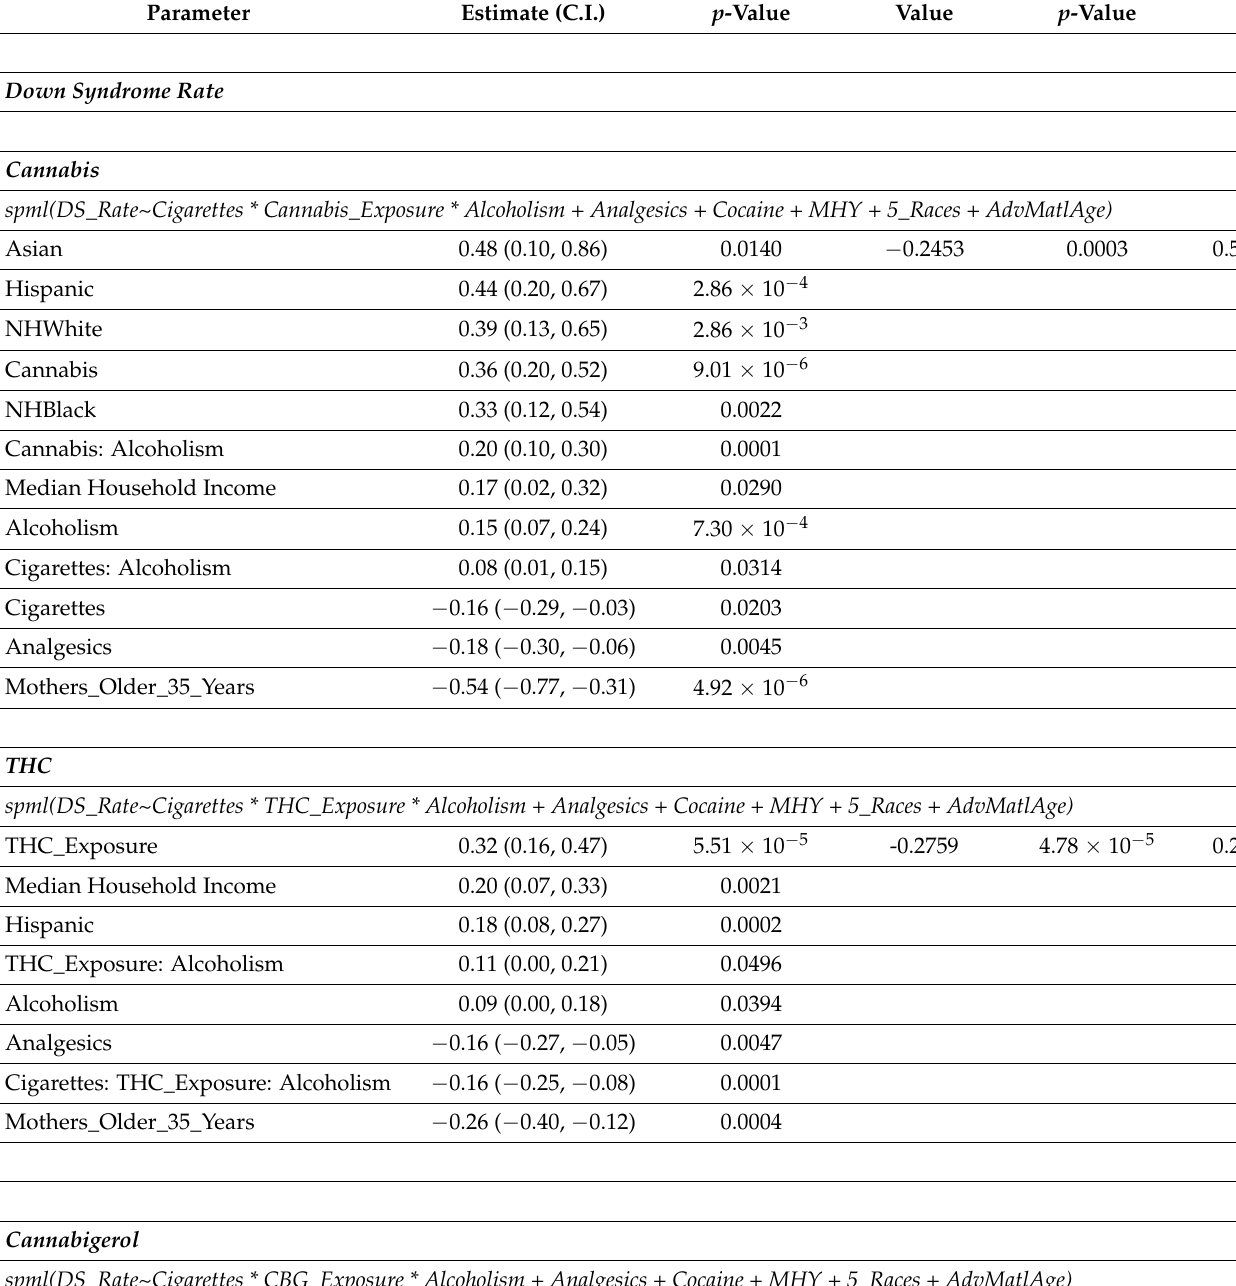
Table 1 shows the results from spatial regression of this data for multivariable models including cannabis, THC and cannabigerol including all the main socioeconomic, ethnicity and drug exposure variables. Table considers first the unadjusted DSR and then the DSR after adjustment for estimated ETOPFA rates. In each case first cannabis, then THC and then cannabigerol are considered. The columns of the right hand of the table list the value of the spatial coefficient rho along with its statistical significance. Table 1. Geospatial spreml Regression of Down Syndrome Rate on Drugs, Cannabinoids, Race and Income. Parameter Model Spatial Parameter, Rho